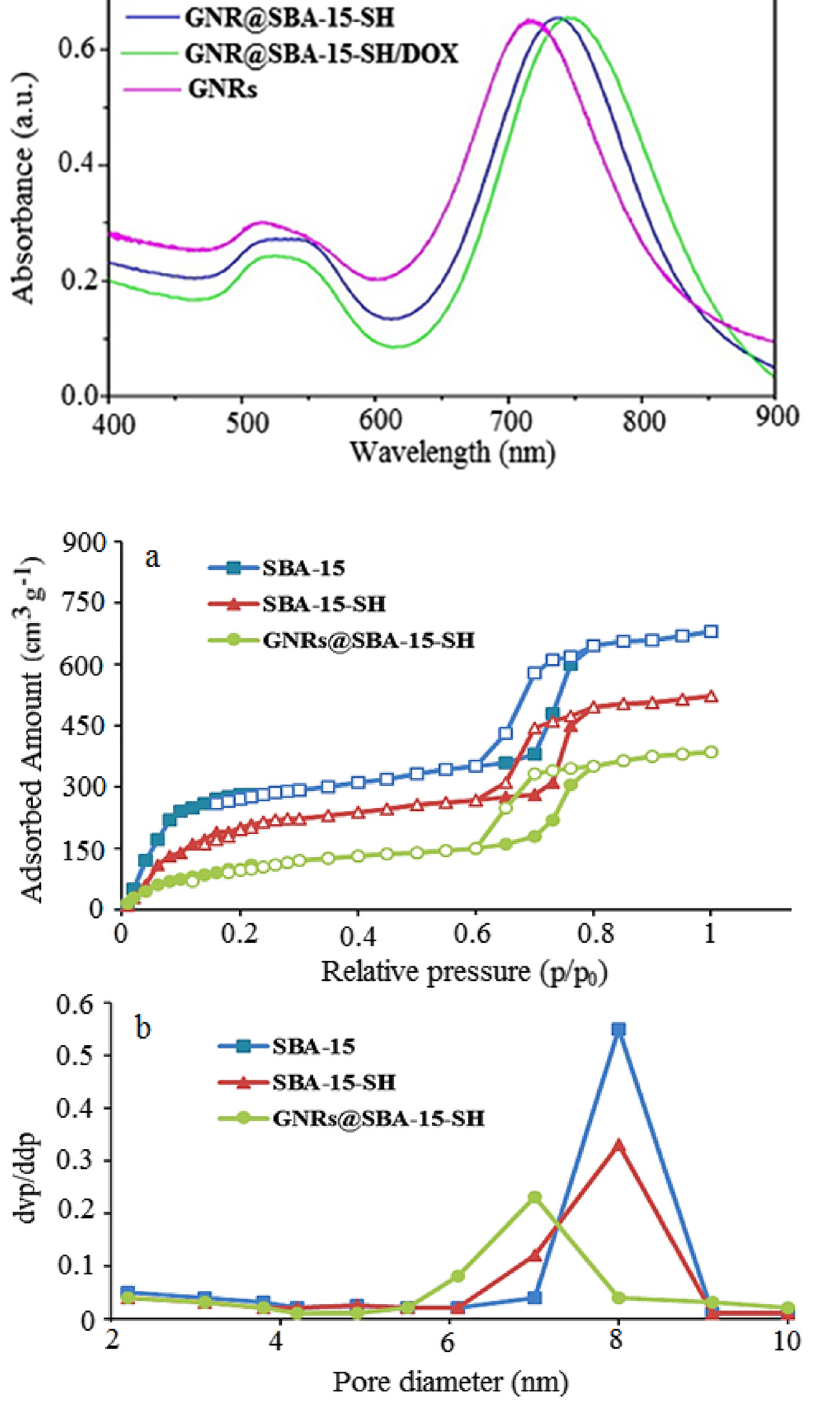
Figure 6: (a) N 2 adsorption – desorption isotherms and (b) pore size distributions of SBA-15, SBA-15-SH, and GNRs@SBA-15-SH